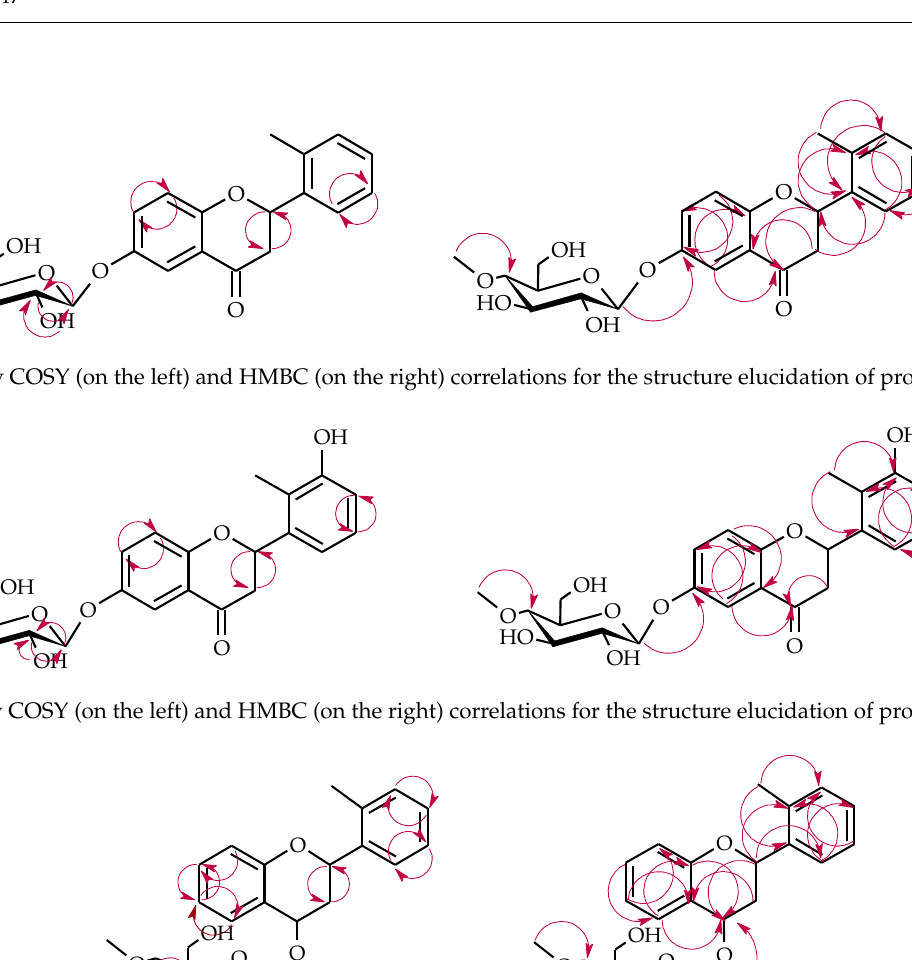
Scheme 4. Key COSY (on the left) and HMBC (on the right) correlations for the structure elucidation of product 4b .